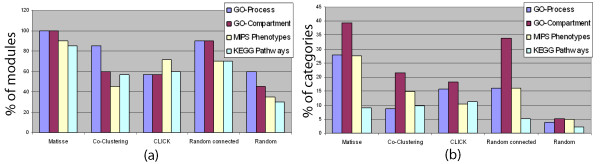
Performance of different module finding algorithmson S. cerevisiae osmotic shock data. (a) The fraction of the modules for which at least one category was enriched, (b) The fraction of the categories enriched in at least one module. Enrichment was defined as attaining hypergeometric p-value ≤ 10-3. Annotation sets: GO-Process: Level 7 of the GO "biological process" ontology; GO-Complex: subterms of "protein complex" term, GO:0043234; MIPS Phenotypes: MIPS deletion phenotype annotations; KEGG Pathways: KEGG molecular pathway participation.